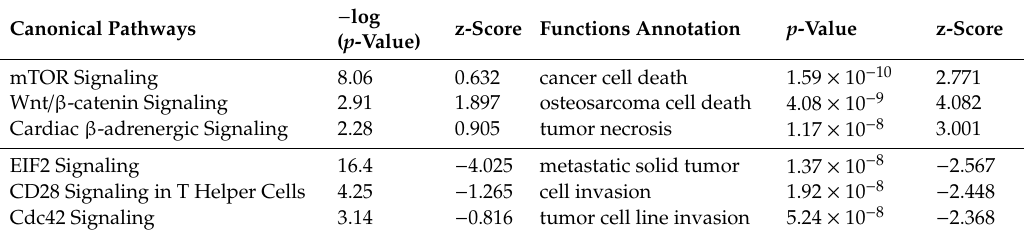
Table 2. Top activated and inhibited canonical pathways and cellular functions in ex vivo